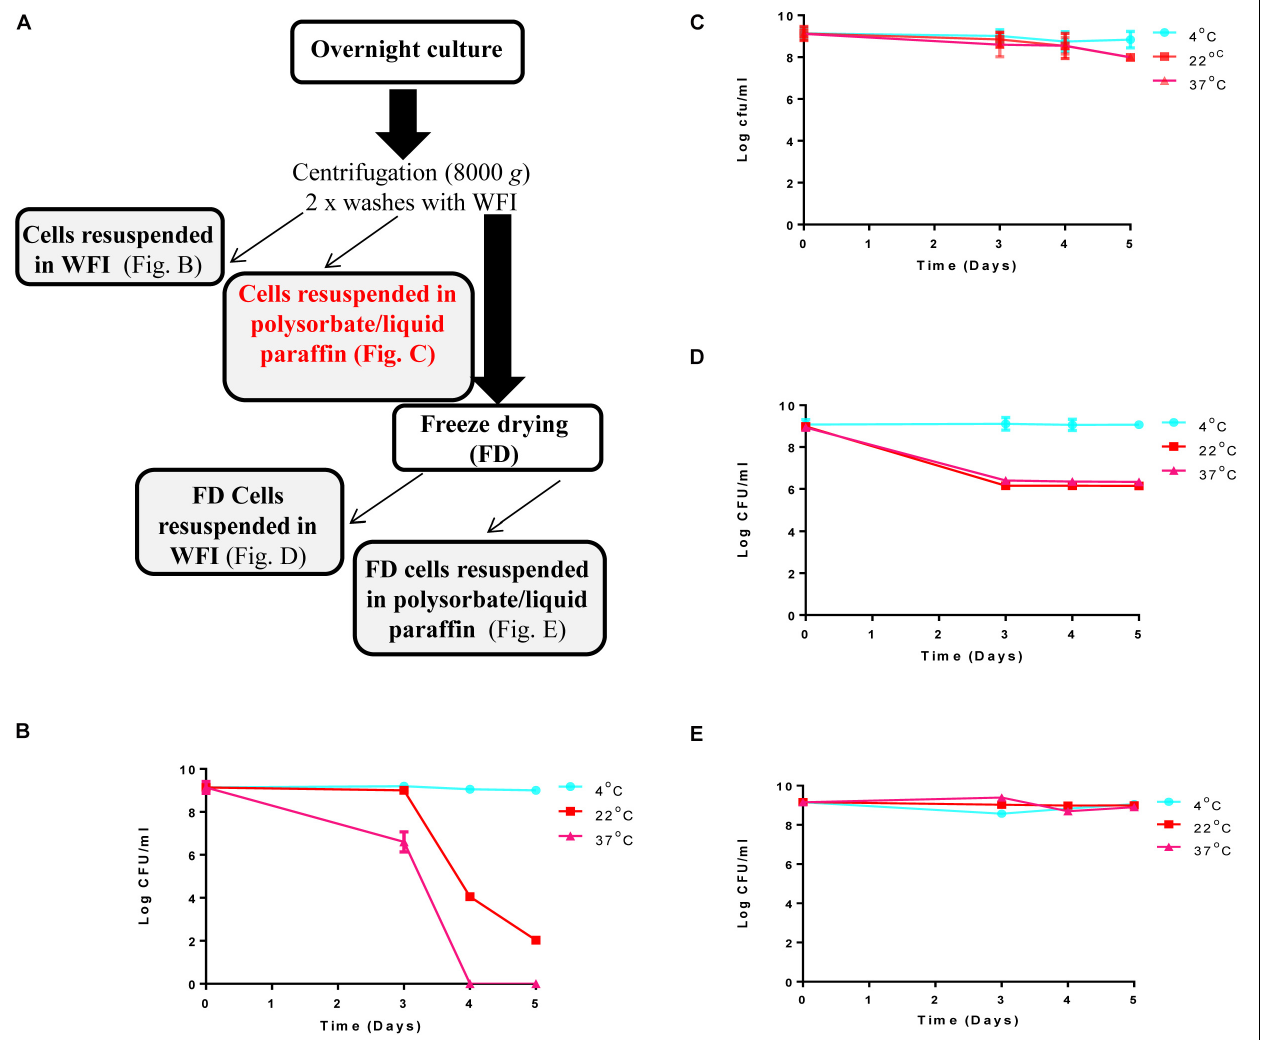
FIGURE 1 | Steps involved in preparation of the ‘live bio-therapeutic’ formulation and short-term viability testing of the product: (A) Flow chart of the ‘live bio-therapeutic’ preparation including reconstitution of freeze-dried or non-freeze dried L. lactis DPC3147 cells in either WFI or liquid paraffin/polysorbate 80. The formulation used in the animal trial is highlighted in red in the flow chart. Short-term viability of (B) non-freeze dried L. lactis DPC3147 cells stored in WFI; (C) non-freeze dried DPC3147 cells in an emulsion (‘live bio-therapeutic’ formulation used in this study); (D) freeze-dried DPC3147 cells stored in WFI and (E) freeze-dried DPC3147 cells in emulsion. Error bars represent standard deviations of mean values in each